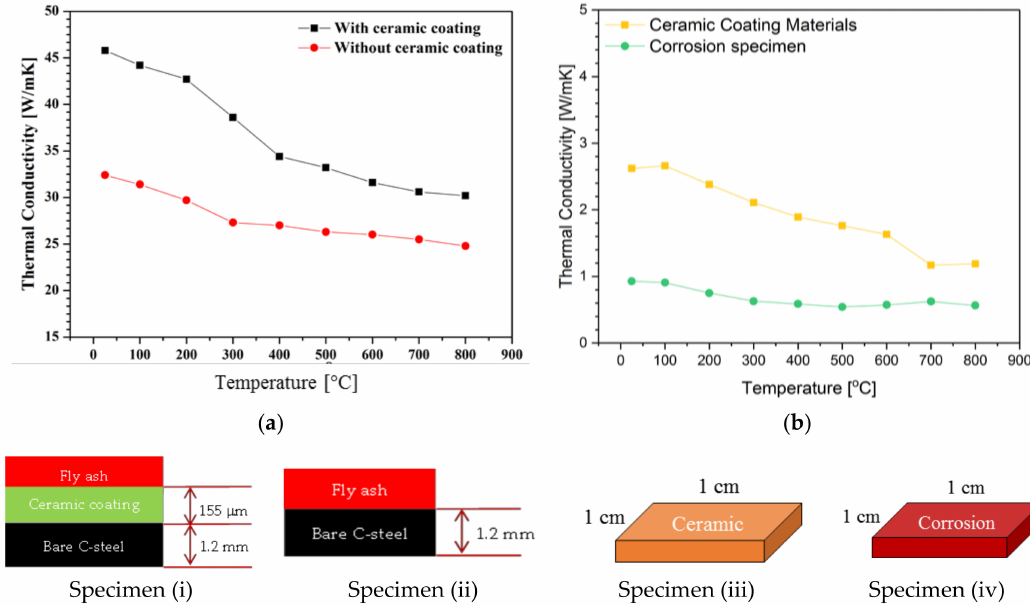
Figure 10. Thermal conductivities of all prepared samples as a function of the temperature up to 800 ◦ C: ( a ) Specimens with and without ceramic coating; ( b ) Ceramic coating materials and corrosion